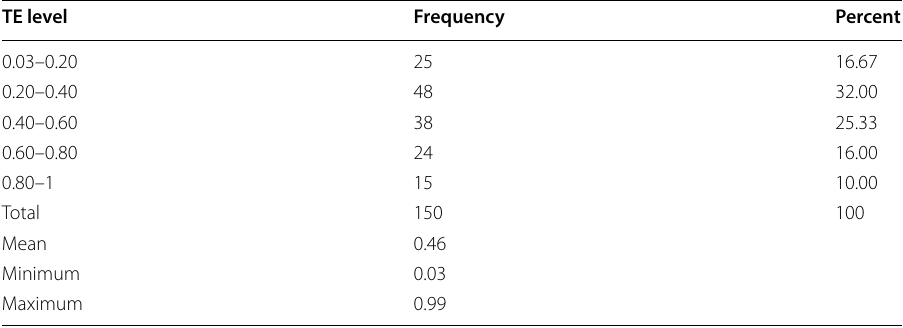
Table 9 Frequency distribution of technical efficiency of potato producers. Source: Computed from Field Survey Data, 2015/16 TE